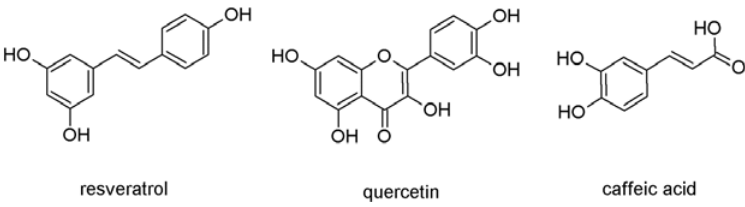
Figure 1. Structures of resveratrol, quercetin and caffeic